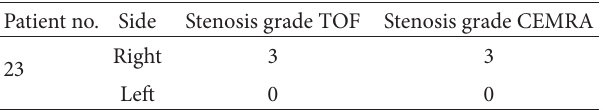
Table 1: Stenosis grade results. Table 1: